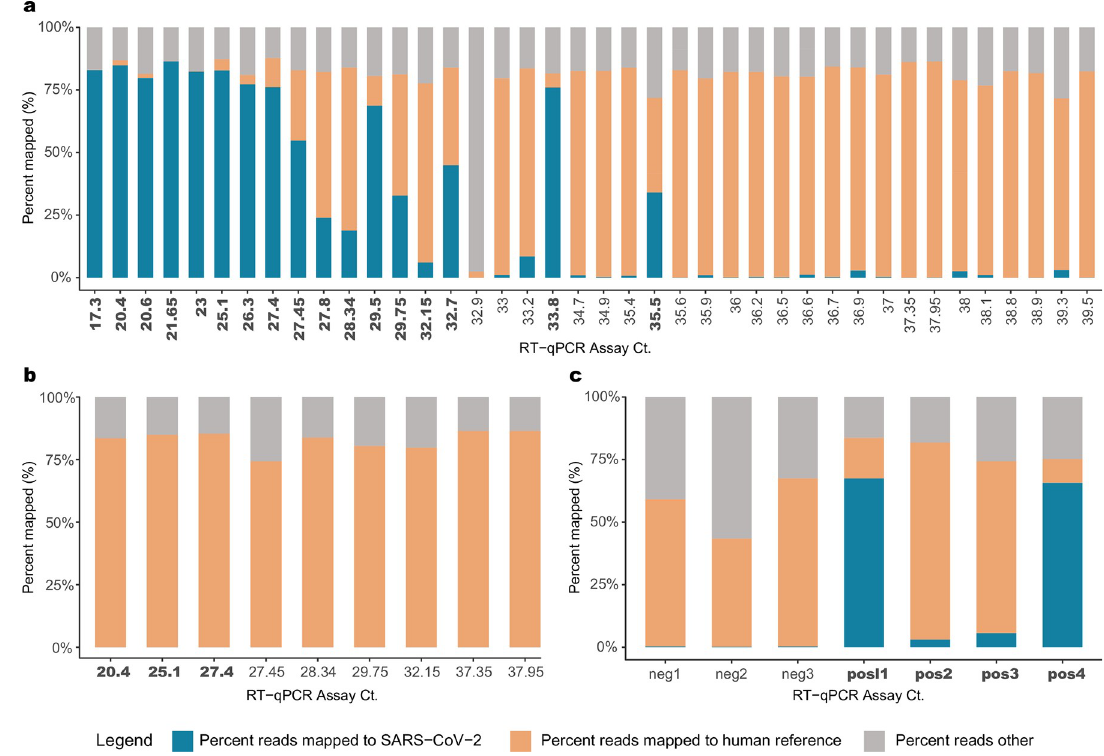
Fig 2. Sequence data. Ct value vs percent raw sequencing reads mapped to SARS-CoV-2 in ( a ) Capture enriched samples; ( b ) Pre- capture samples; ( c ) Positive and Negative controls. Percentage of reads mapped to the ‘SARS-CoV-2’ genome, to the ‘human’ reference genome and a third category called ‘reads others’, which is the combined total of trimmed reads and reads that do not fall under the two other categories are plotted in this figure. Ct values in bold indicate samples that provided full-length genome assemblies.